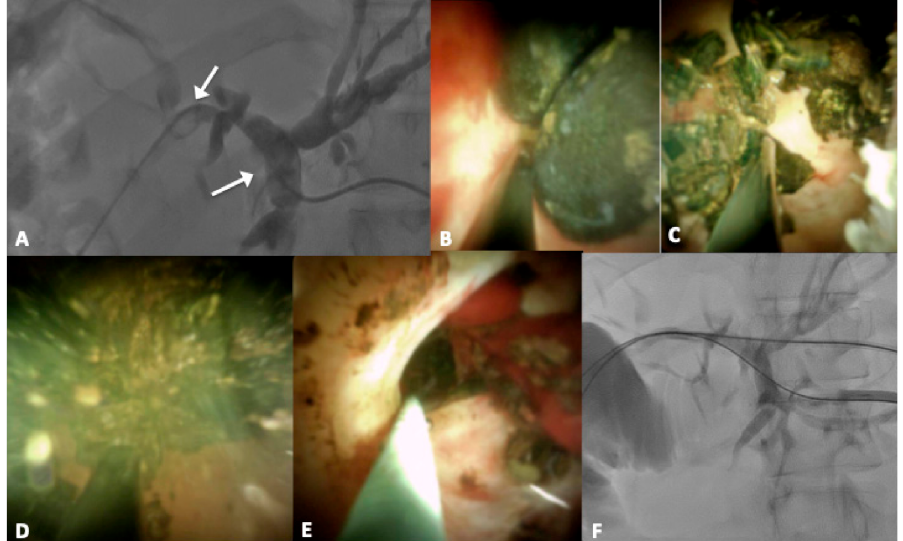
Figure 3. Percutaneous approach of the spyglass ( A ); intra-ductal visualization of the stones ( B ); intra-procedural lithotripsy ( C ), wash with saline ( D ) and residual biliary debris ( E ); cholangiography performed 3 days after PTL reveals absence of filling defects ( F